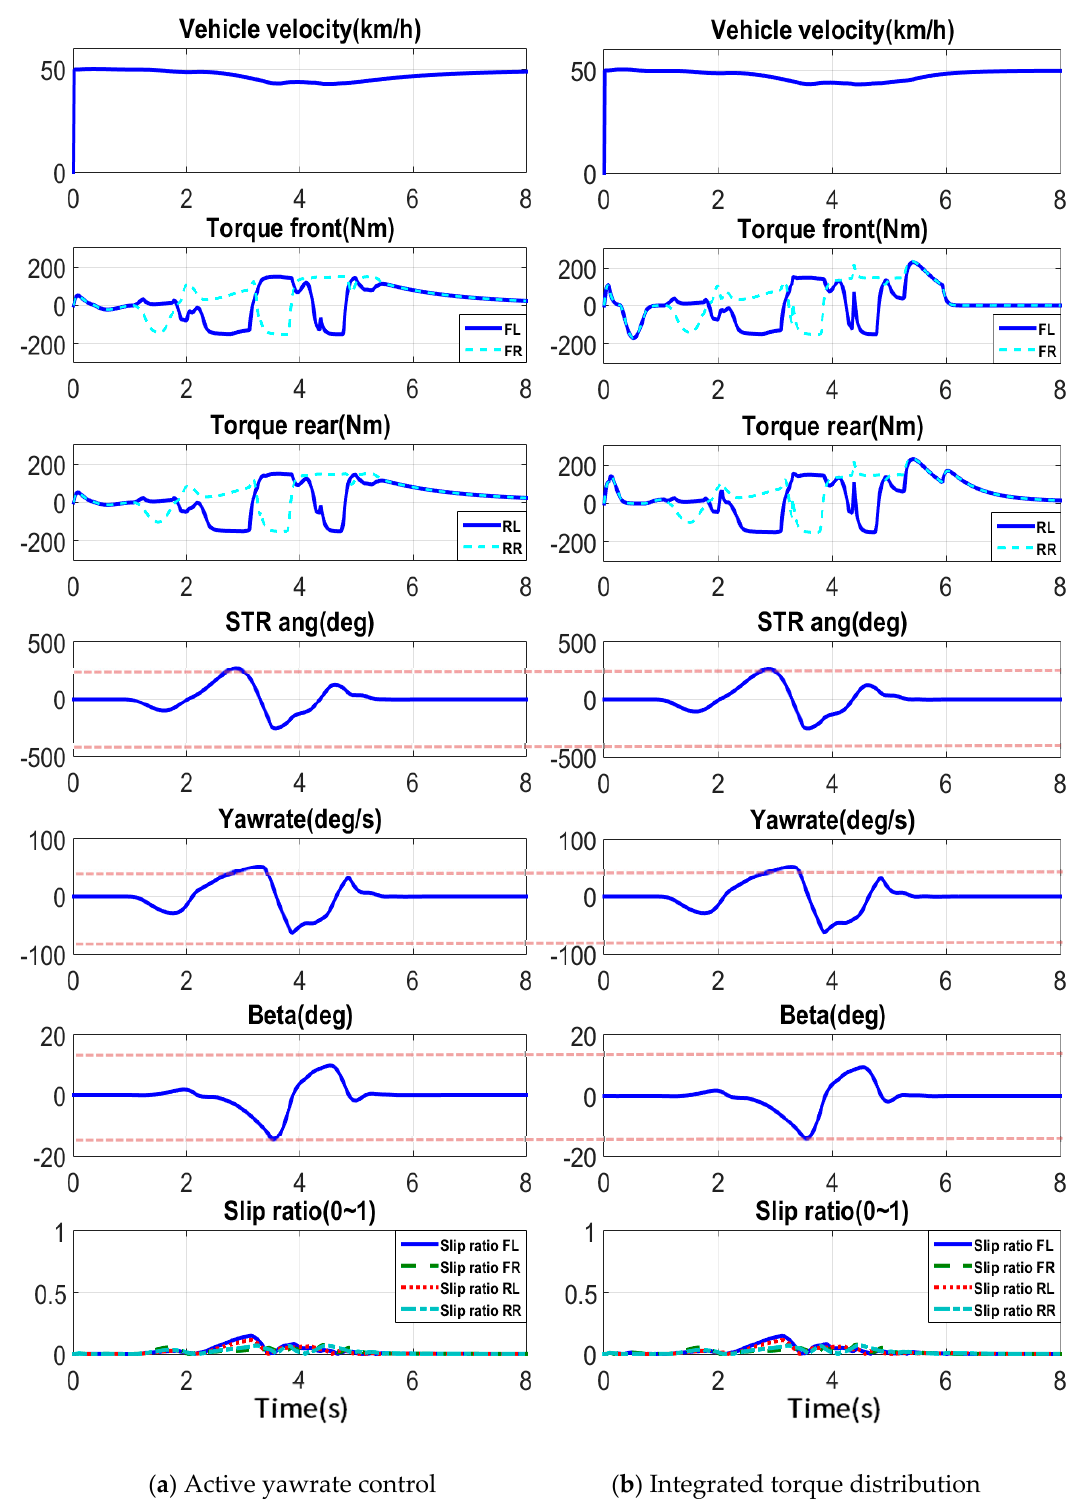
Figure 11. Simulation results of short double-lane change (AYC, ITD).